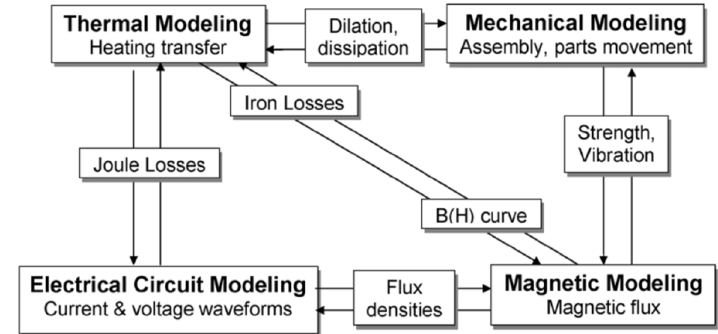
Figure 1. Flowchart for PMSM design in a CAD environment.